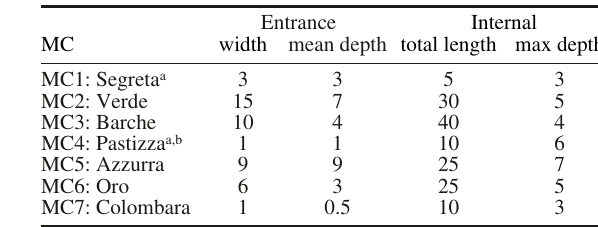
Table 1. – Main features of the marine caves investigated in the study. The measurements shown are in metres. a Submerged en- trance. b Marine cave consisting of two successive cavities connect- ed by a short underwater tunnel. The innermost cavity, completely submerged and difficult to access, was not considered during the present